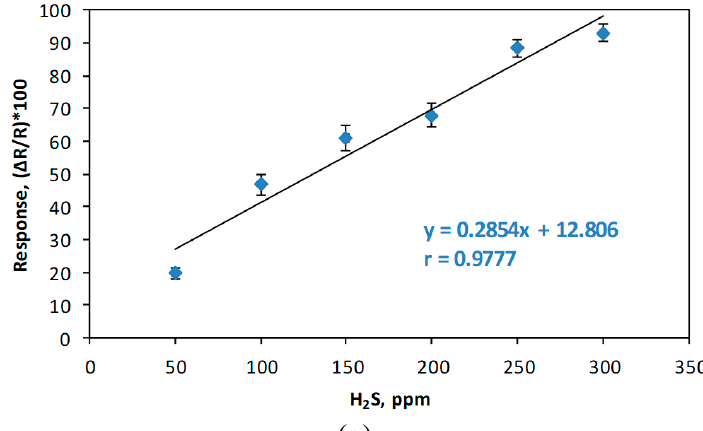
Figure 5. XRD pattern of electroactive ( a ) PI and ( b ) PI/AuNPs.